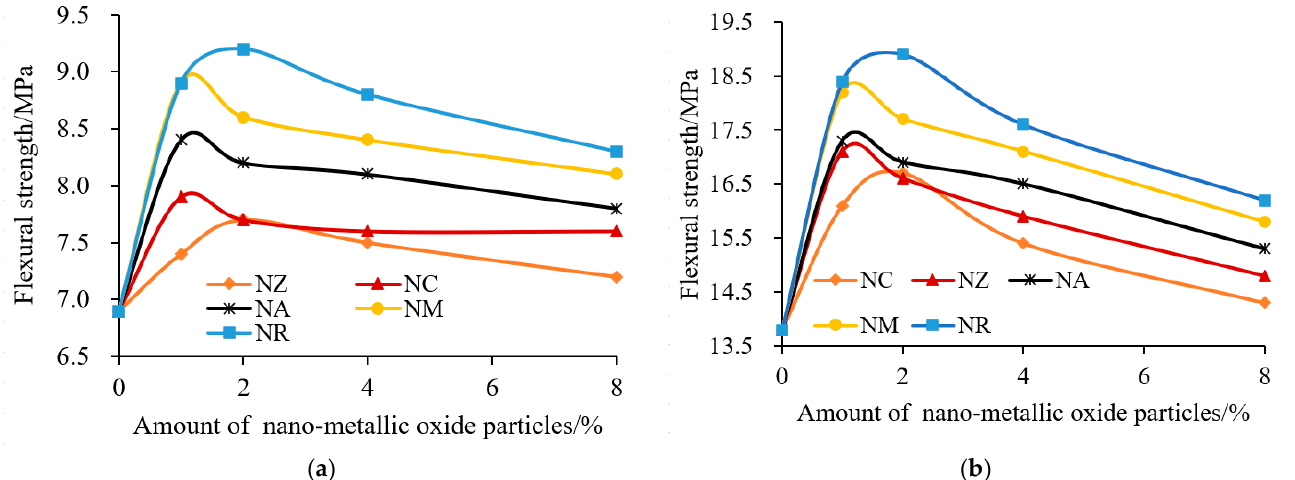
Figure 3. Flexural strength of cement mortar with nano-metallic oxide particles: (a) 28 days; (b) 730 days.